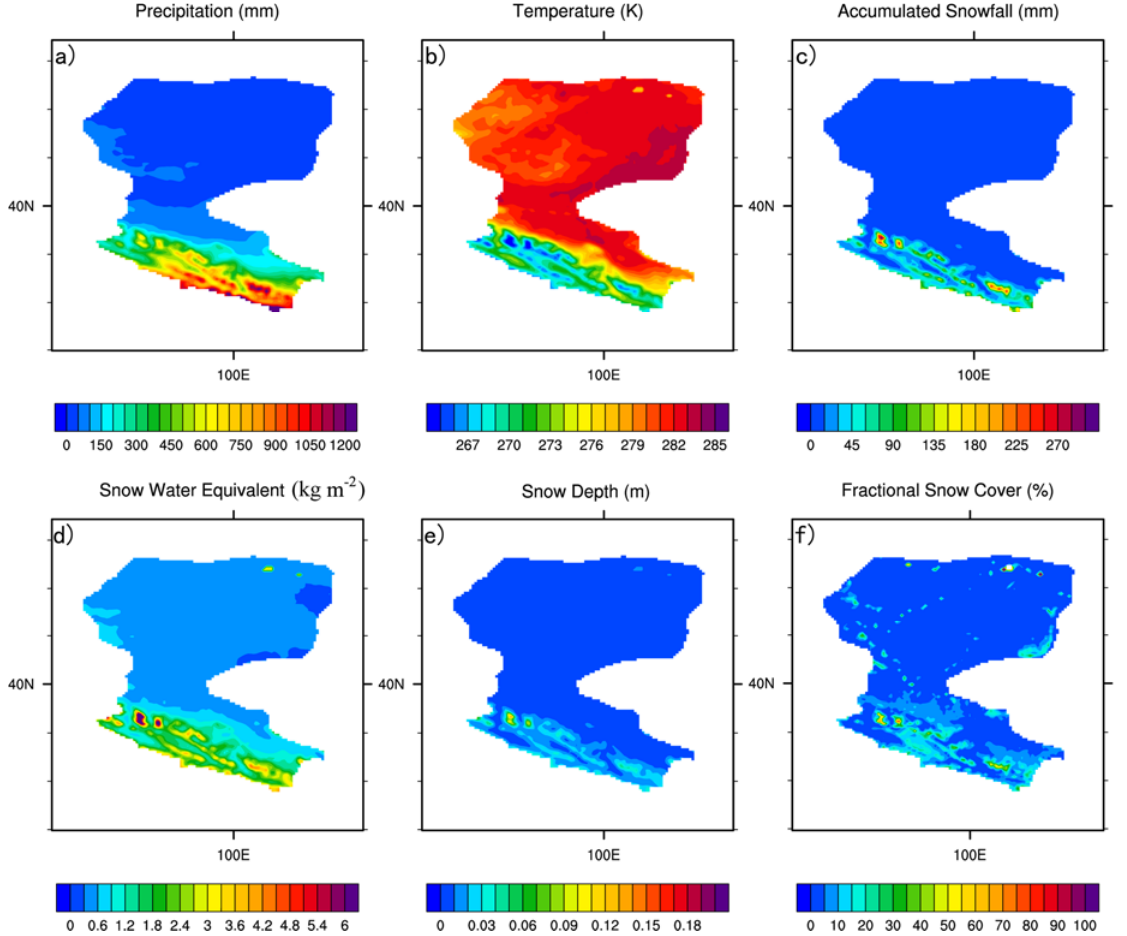
Figure 3. Spatial distribution of annual mean values from 2000 to 2013: ( a ) precipitation; ( b ) 2m temperature; ( c ) snowfall; ( d ) snow water equivalent (SWE); ( e ) snow depth; ( f ) fractional snow cover (FSC).